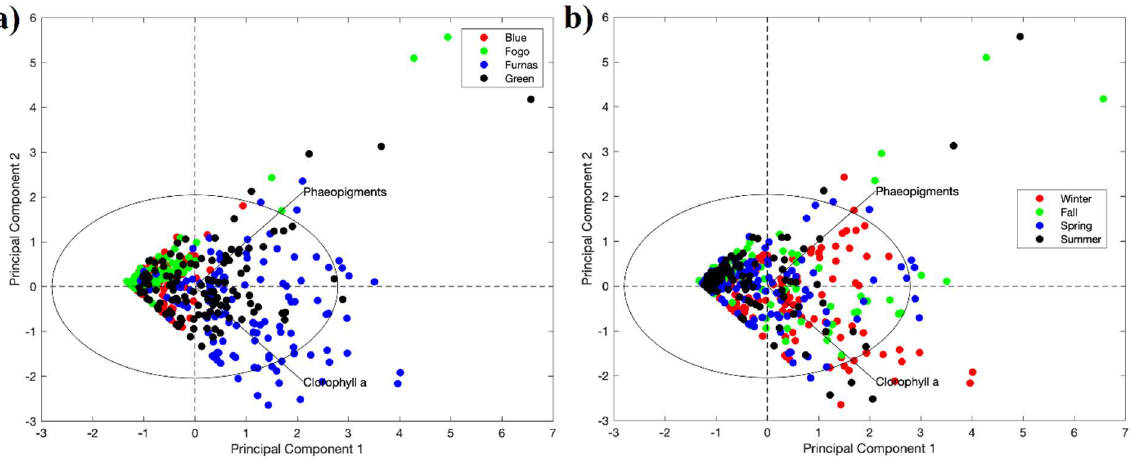
Figure 5. Biplots for the multivariate analysis of chlorophyll a and phaeopigments (cla and Phaeo), colored according to the lake ( a ) and season ( b ).